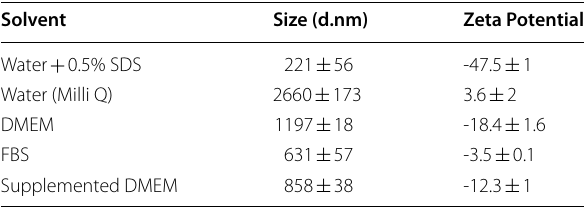
Table 1 Hydrodynamic diameter (Size) and Zeta Potential of PET‑NPs in different